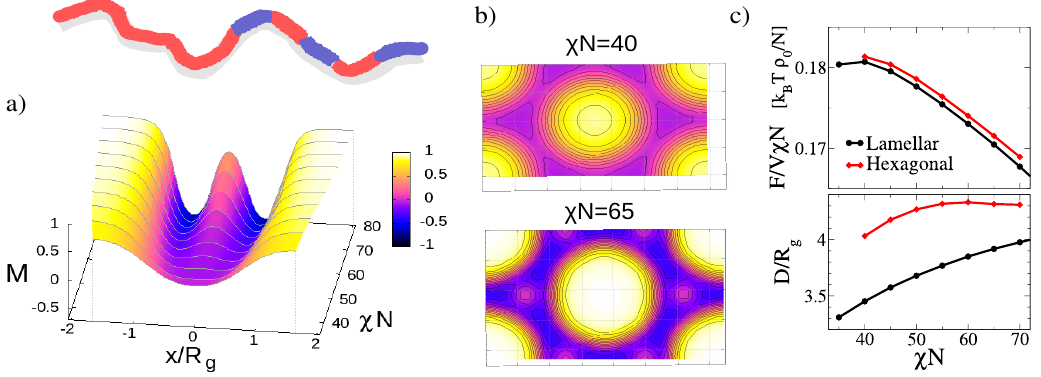
Figure 2. Stable and metastable ordered phases in melts of multiblock copolymers with sequence A 5 m B m A m B m A m B m . ( a ) Order parameter profiles for stable lamellar structures as a function of χ N . A double lamellar structure emerges for χ N > 42.5. ( b ) Order parameter maps for selected metastable hexagonal structures for χ N = 40 and χ N = 65. The color map is the same as in panel ( a ). ( c ) Free energy per volume ( top ) and periodic distance ( bottom ) in lamellar and hexagonal phases as a function of χ N . In hexagonal phases, D denotes distance between